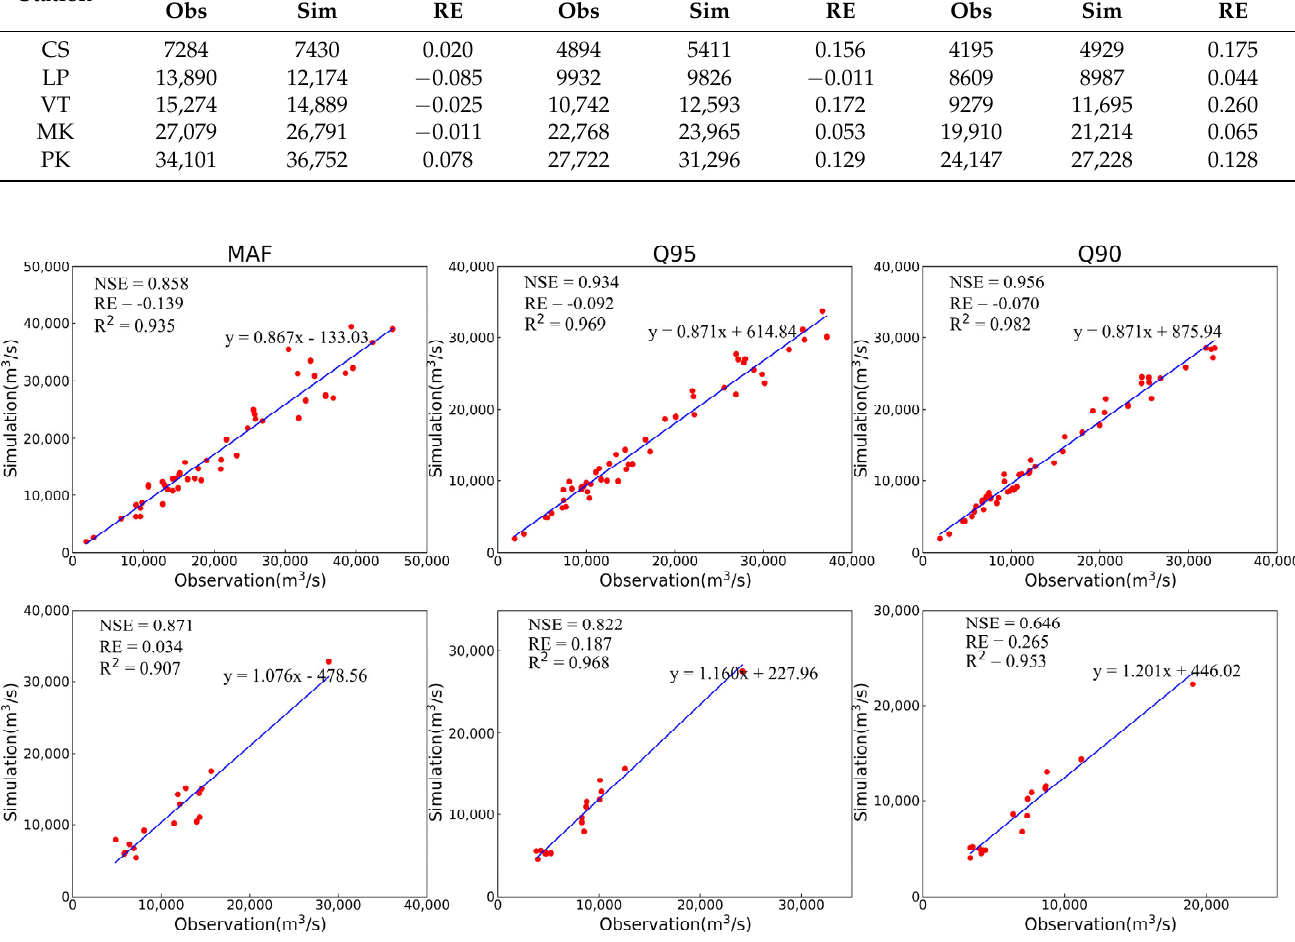
Figure 5. The relationship between measured and simulated flood (i.e., MAF, Q95, and Q90) for all selected stations in testing period and human impact period. The Nash–Sutcliffe efficiency (NSE), relative error (RE), and correlation coefficient (R 2 ) are also shown. Table 3. Flood indicators performance of HPD model for testing period (1998–2007).